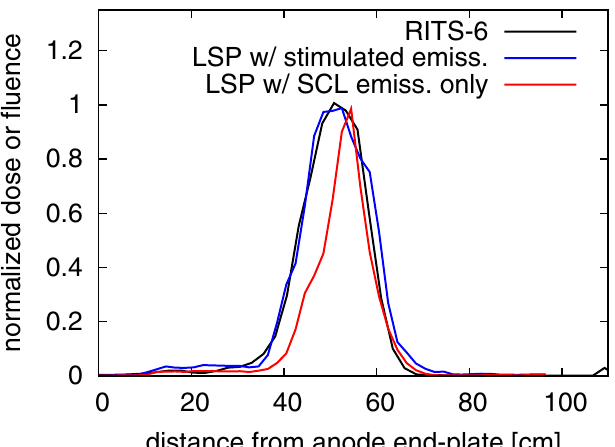
FIG. 2. (Color) (a) Diagram of the anode dustbin and the cath- ode field-shaper knob fielded on RITS-6. The center conductor FIG. 3. (Color) Measured electron dose (black) and simulated terminates in a hollow cylinder or large-area diode. (b) Cross electron fluence (blue and red) along the dustbin outer wall. The sectional view (cid:2) r; z (cid:3) of simulation geometry including dustbin blue curve is from simulation including stimulated emission and knob which begins 138 cm downstream from the sixth from the dustbin wall and knob, while the red curve is from induction cell. The forward-going voltage wave is injected at z (cid:4) 0 . Electron flow is shown 60 ns into the pulse for an 80 - (cid:1) SCL emission only. The curves are normalized to give a peak magnitude of one. For reference, the integrated values for the red load. Diagnostic locations F and G correspond to those marked ’’ and blue curves are the same. The abscissa is the axial distance in Fig. 1. Two additional cathode current probes, labeled ‘‘ I feed ,’’ are shown upstream and downstream from the and ‘‘ I from the anode end plate (the final downstream component). The beam knob, respectively. knob is centered between 40 and 60 cm on this